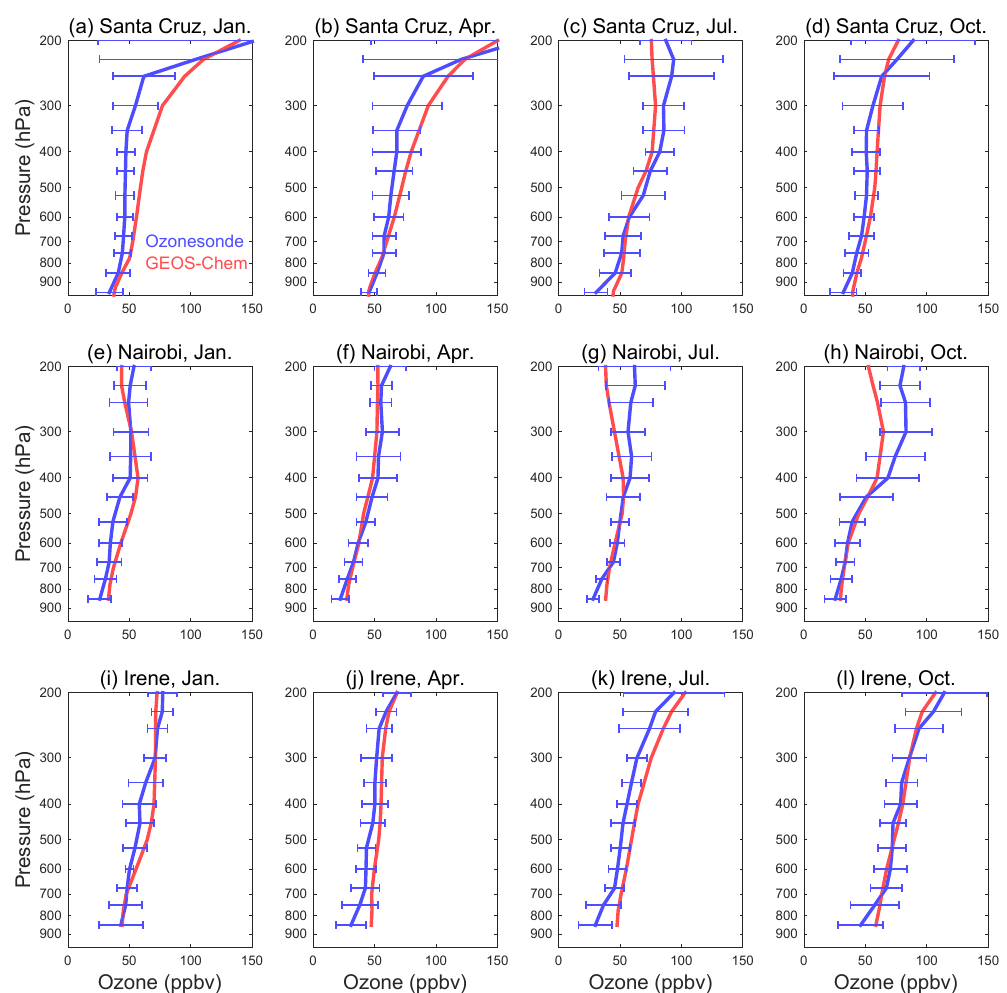
Figure 2. Comparison of the monthly mean ozone vertical profiles between the GEOS-Chem simulations (red line) and the ozonesonde measurements (blue line) averaged over 1999–2003 at Santa Cruz (a–d) , over 2003–2006 at Nairobi (e–h) , and over 1999–2005 at Irene